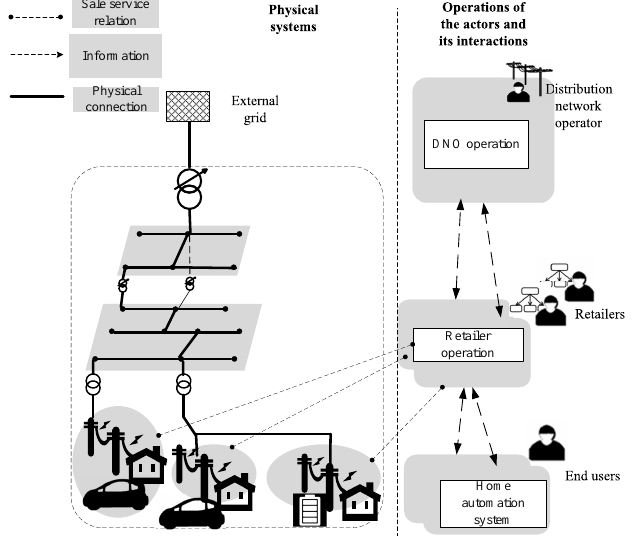
Figure 1. An overview of the network-constrained transactive energy-based distribution system. DNO: distribution network